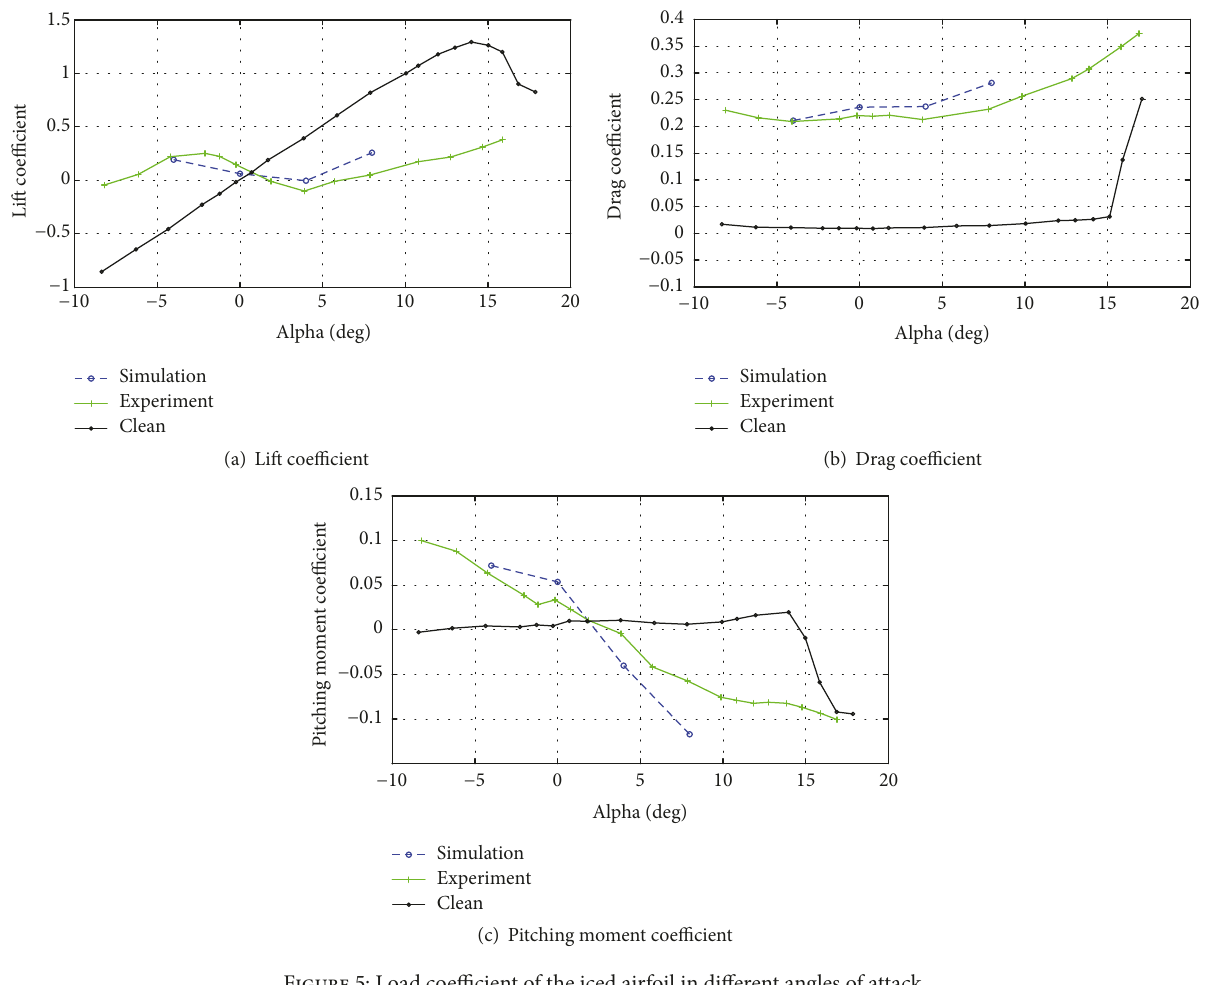
Figure 5: Load coefficient of the iced airfoil in different angles of